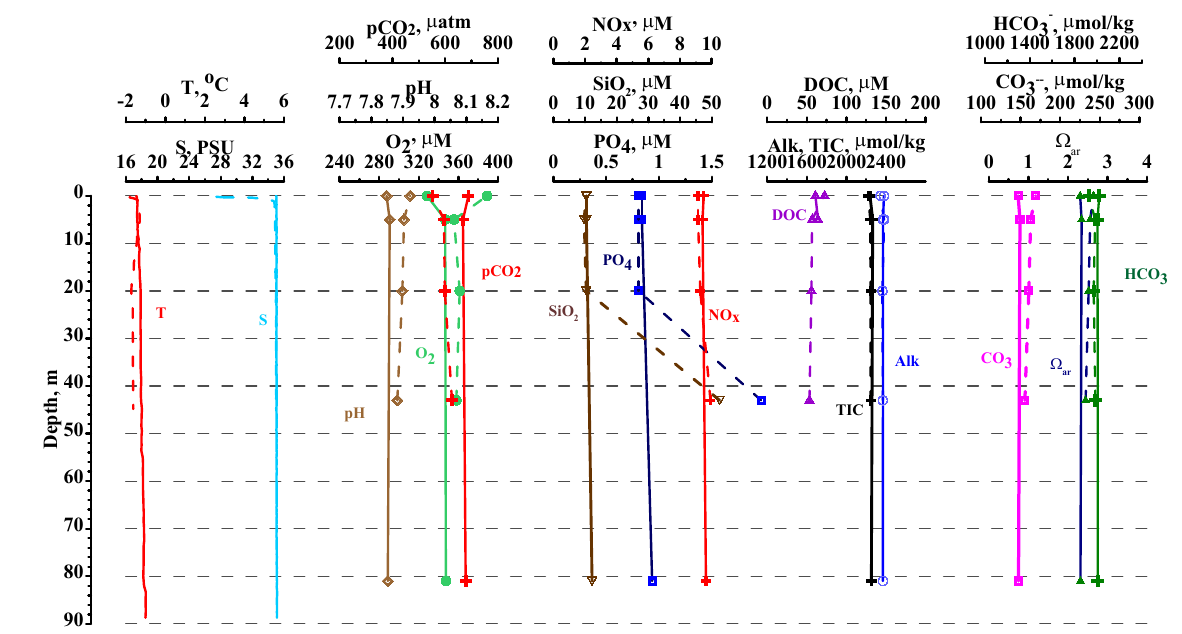
Figure 3. Vertical distribution of physical and chemical parameters at stations TM3, near the glacier